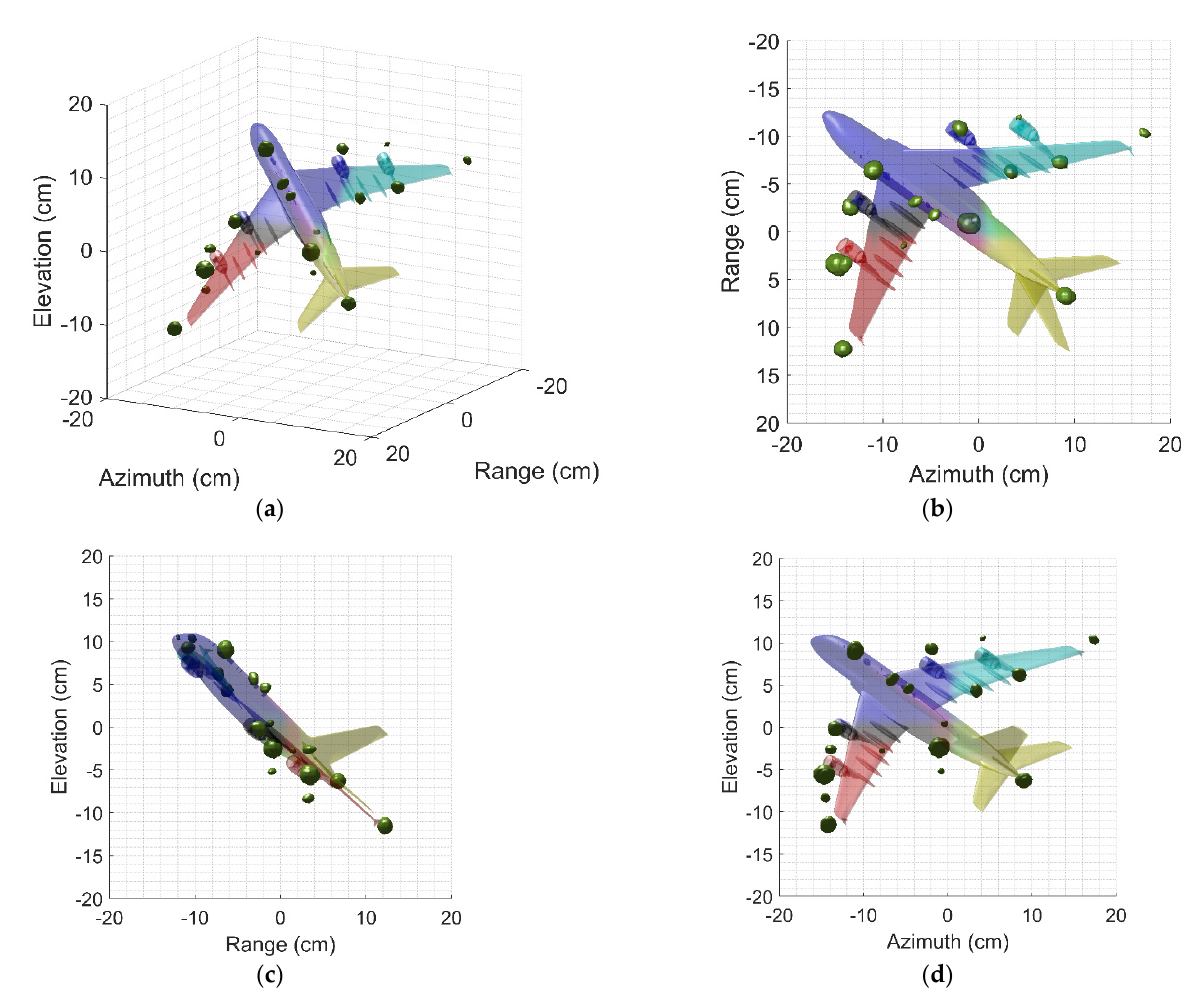
Figure 11. Three-dimension Images profiled on the CAD model. ( a ) Three-dimension image. ( b ) Range–azimuth profile. ( c ) Range–elevation profile. ( d ) Azimuth–elevation profile.